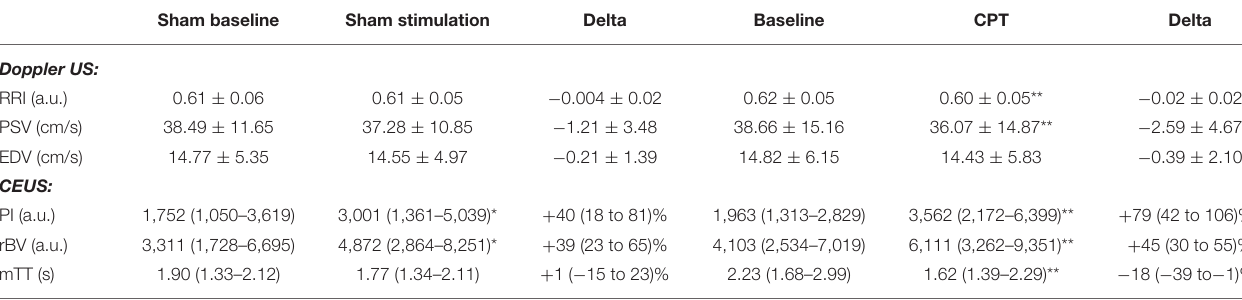
TABLE 3 | Renal hemodynamic during baseline and sham stimulation compared to CPT stimulation. Sham baseline Sham stimulation Delta Baseline CPT Delta